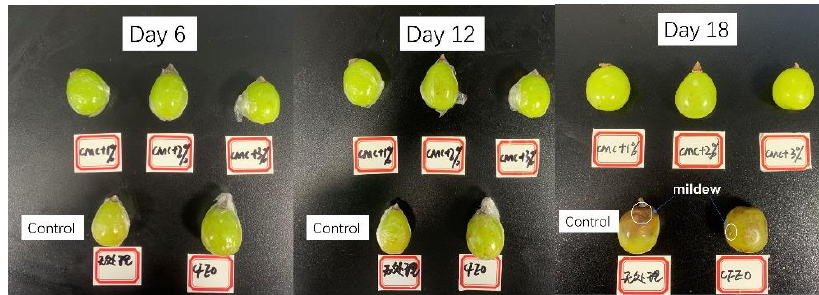
Figure 11. Appearance of Shine Muscat grapes coated with different treatment groups. Table 6. Comparison of some recently studies dealing with natural extracts or essential oils in cellulose derivative films. Natural Extracts Polymer